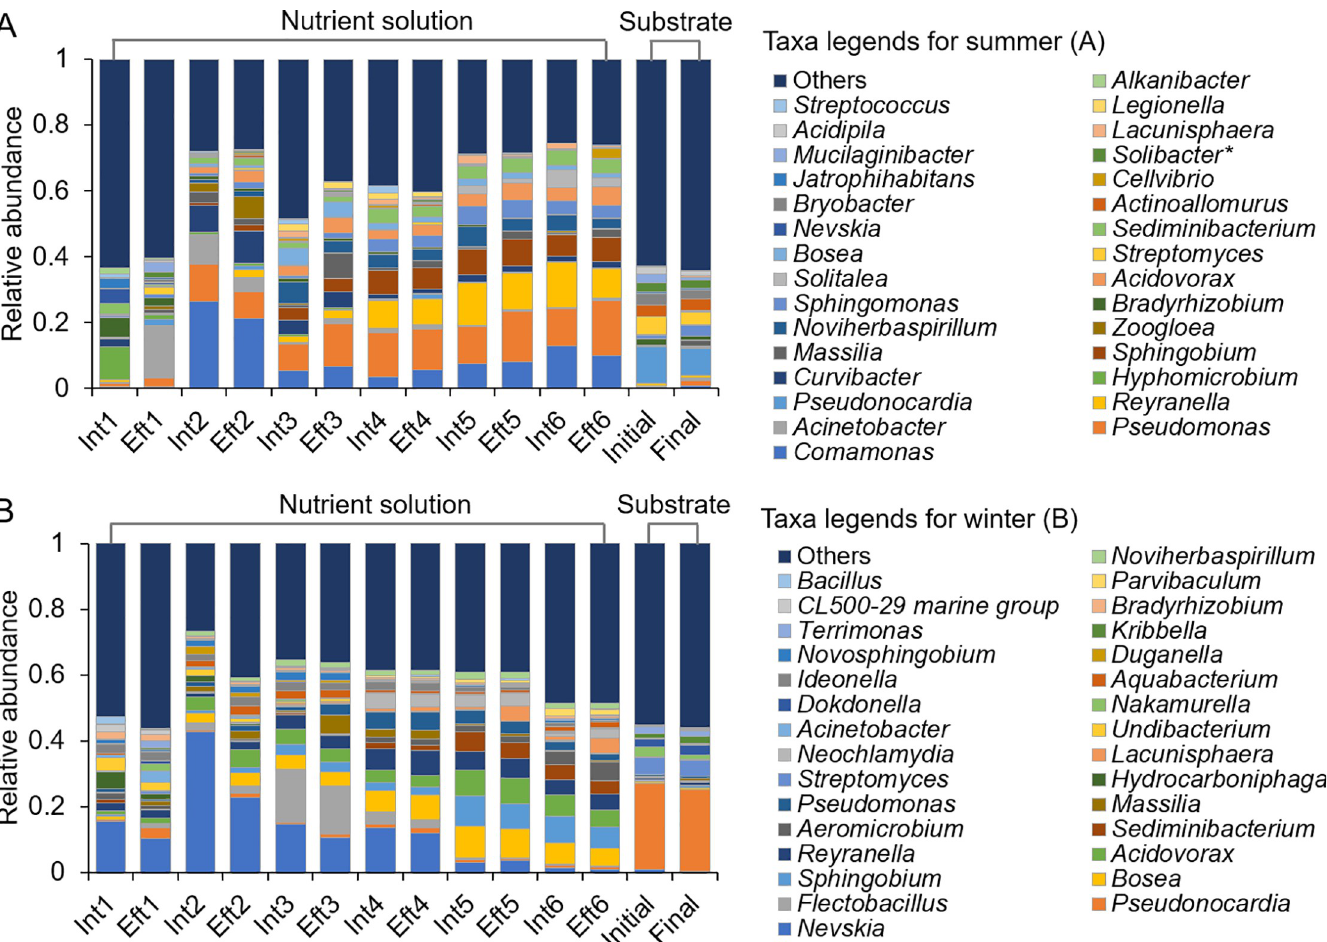
Fig 5. Distribution of bacterial communities at the genus level in the recirculating nutrient solution and substrate samples of cucumber plug seedlings cultivated in an ebb-and-flow system in the summer (A) and winter (B) cultivation seasons. The y-axis shows the relative abundances of the top 30 genera. Asterisks in the legend indicate taxonomic bins containing OTUs that could not be resolved to the genus level. Int and Eft represent the influent and effluent nutrient solution samples,